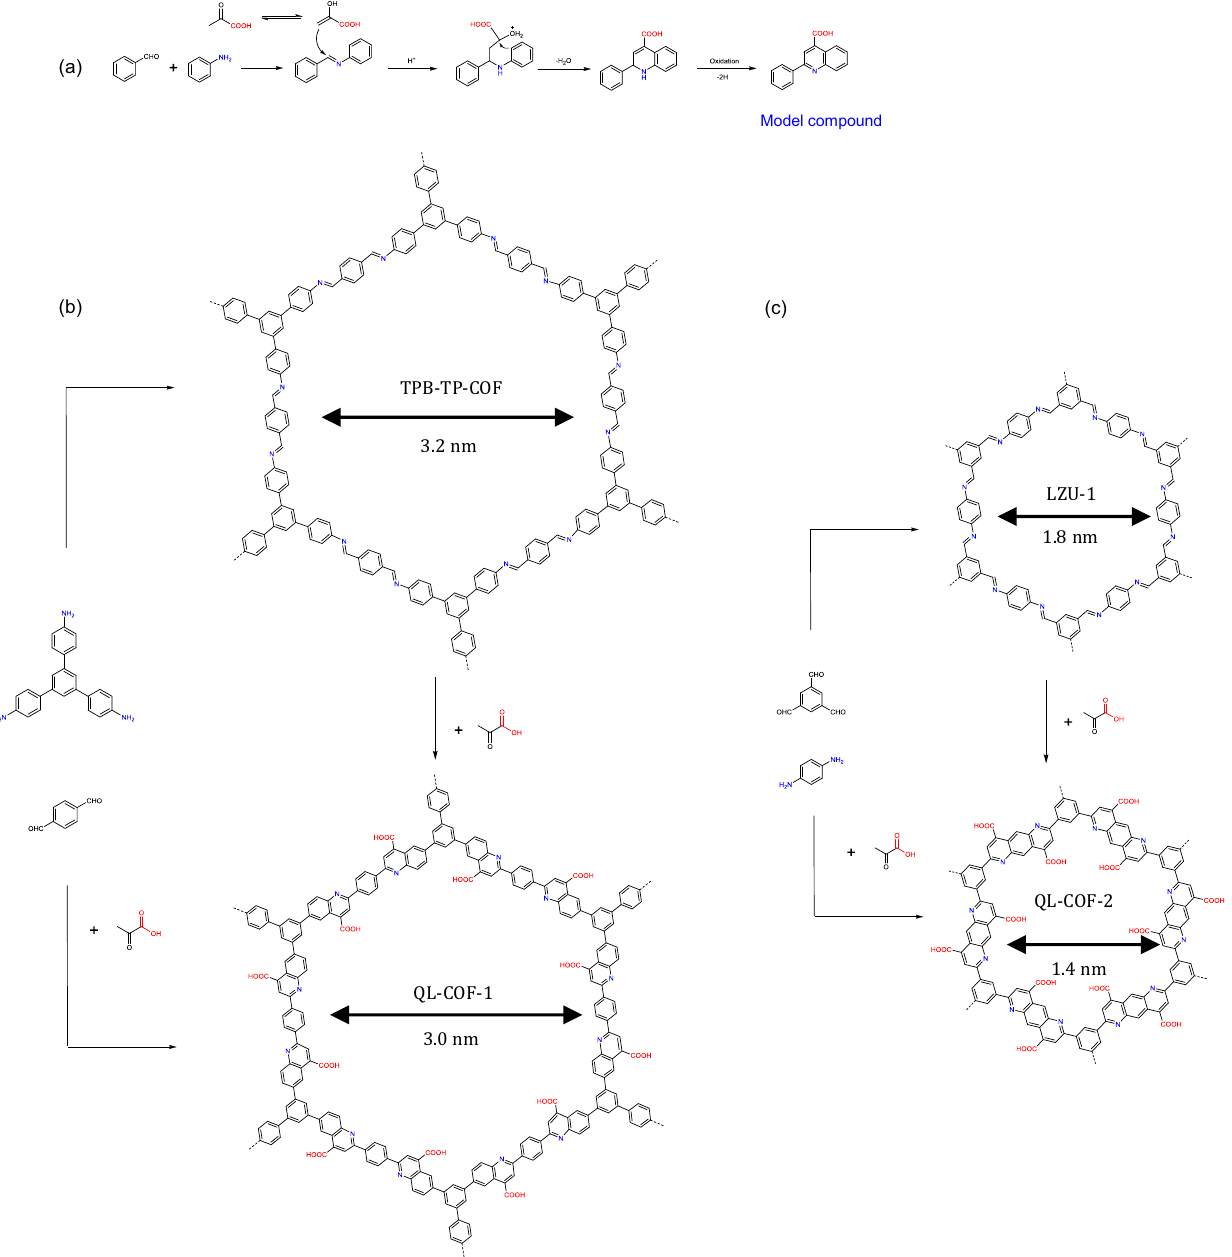
Fig. 1 Synthesis of 4-carboxylquinoline linked QL-COF-1&2. a Proposed mechanism of the model compound formation via Doebner reaction. b and c Synthesis of QL-COF-1&2 in one-pot and post-synthetic modi fi